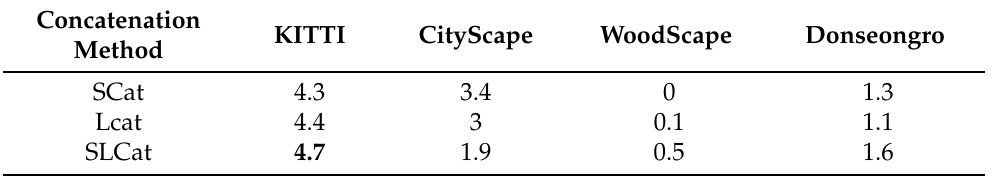
Table 19. Percentile AP performance enhancement of the expandable projection compared with the original fisheye